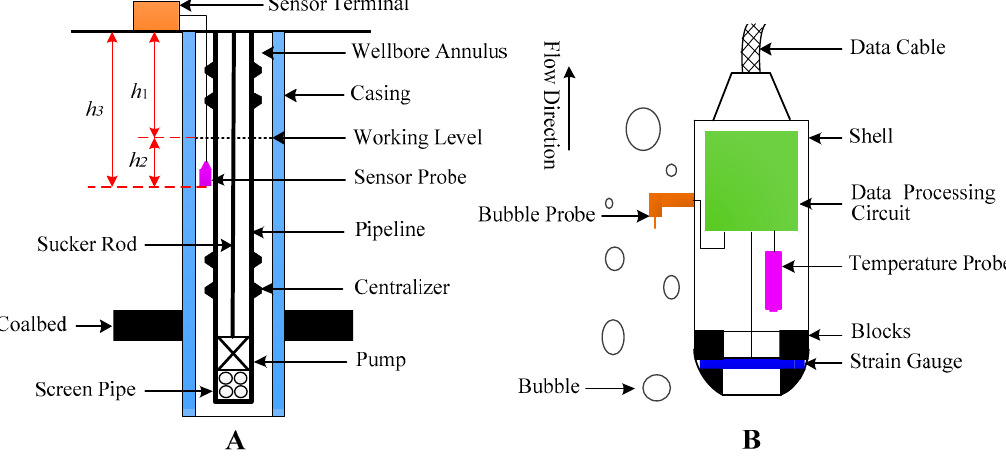
Figure 2. Basic principle of the sensor measurement. ( A ): the installation instruction of the sensor; ( B ): the basic structure of the